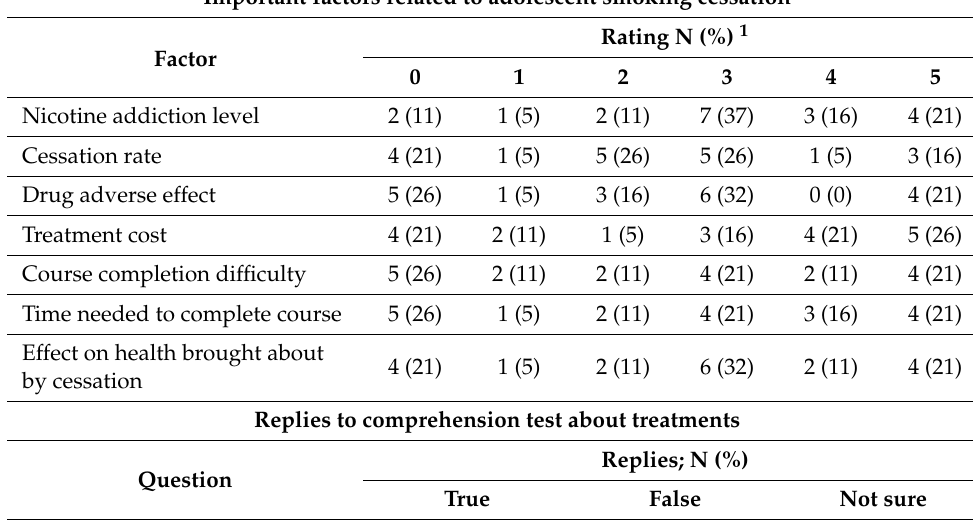
Table 2. SDM-model-related